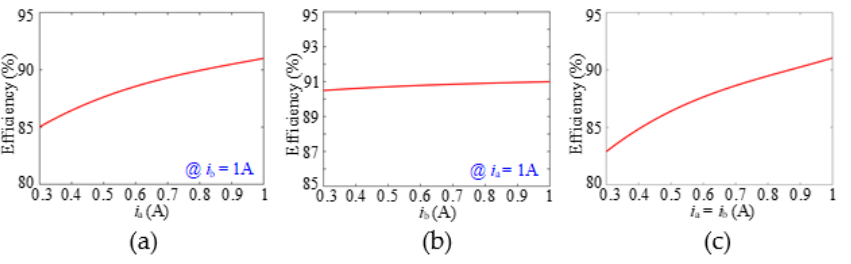
Figure 9. Efficiency curves with variation of load current under voltage ripple-controlled PCCM SIDO buck converters: ( a ) i a = 0.3 – 1 A, i b = 1 A; ( b ) i a = 1 A, i b = 0.3 – 1 A; ( c ) i a = i b .